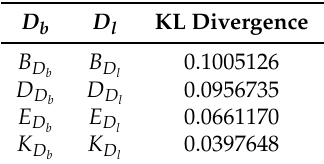
Table 1. Corresponding domain Kullback–Leibler (KL) divergence of D b and D l